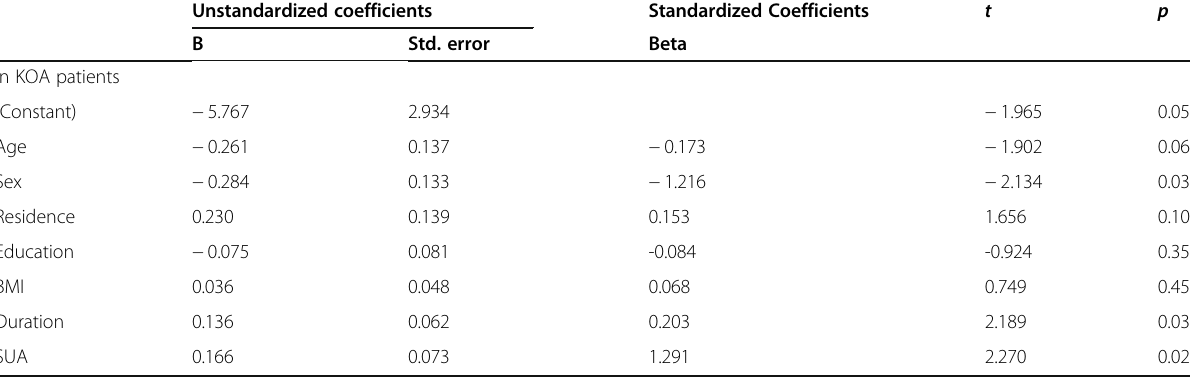
Table 4 Multivariate regression analysis for factors associated with Kellgren-Lawrence grade in patients with knee osteoarthritis Unstandardized coefficients